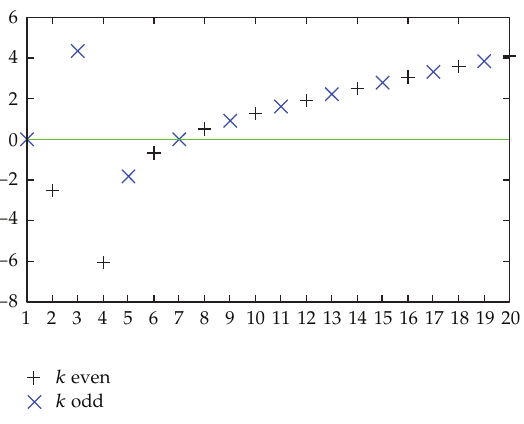
Figure 3: Values L (cid:6)